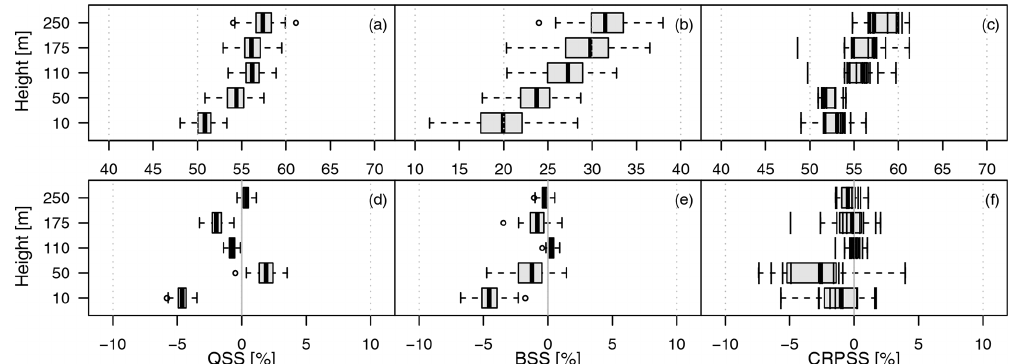
Figure 5. Verification skill scores for the Legendre model against climatology (a–c) and against the layer-wise model (d–f) . The QSS is given for the predictive τ = 99% quantile in (a) and (d) ; the BSS for thresholds corresponding to the observations’ 99% quantile ( u = 14 . 8ms − 1 at 10m, u = 19 . 26ms − 1 at 50m, u = 21 . 01ms − 1 at 110m, u = 22 . 55ms − 1 at 175m, and u = 23 . 97ms − 1 at 250m) in (b) and (e) ; and the CRPSS in (c) and (f) . For QSS and BSS, the box and whiskers represent the 100-member bootstrap sample, with the box giving the interquartile range. The range of the whiskers is a maximum of 1.5 times the width of the box. For the CRPSS, the boxes represent the 11 cross-validated estimates.